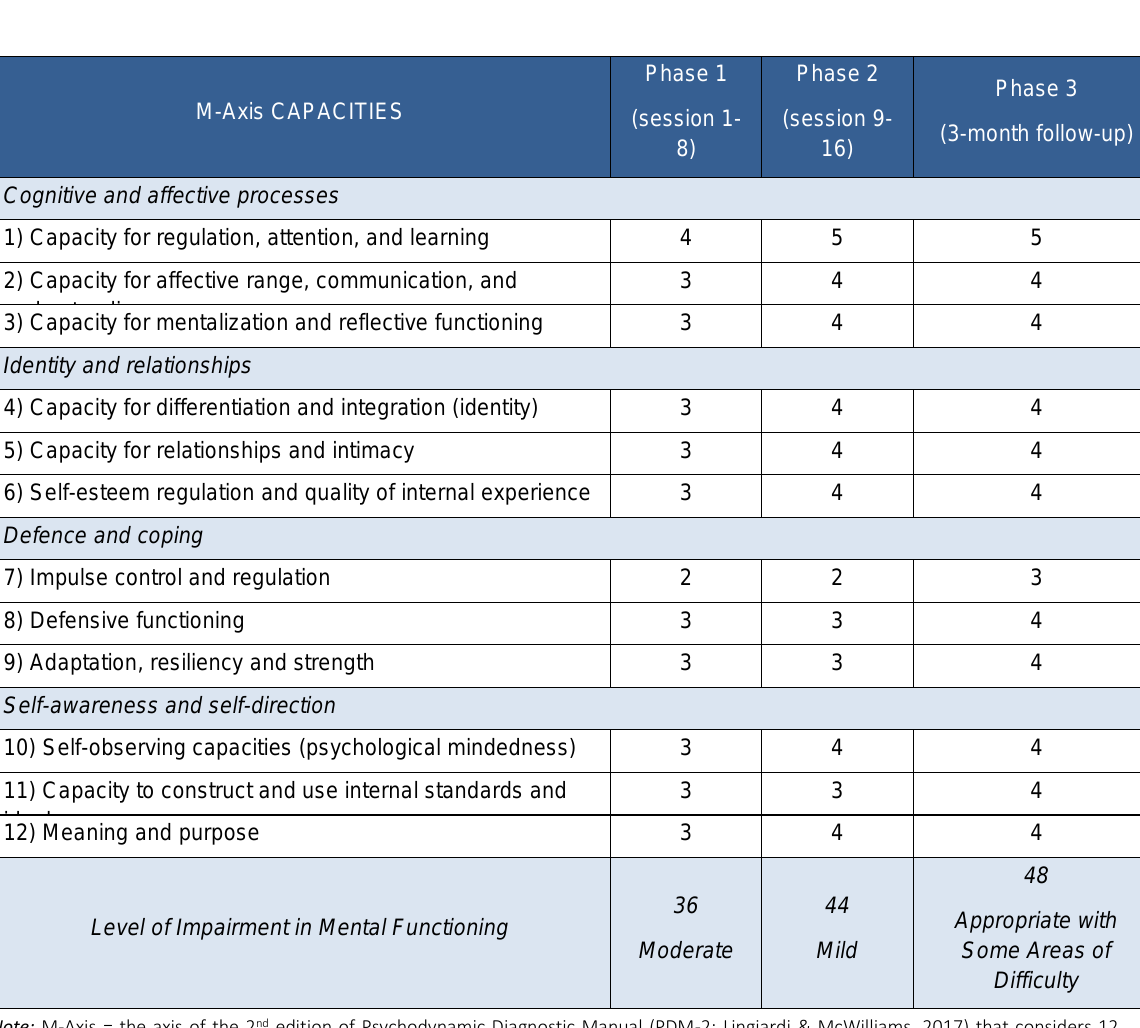
Table 2: Profile of mental